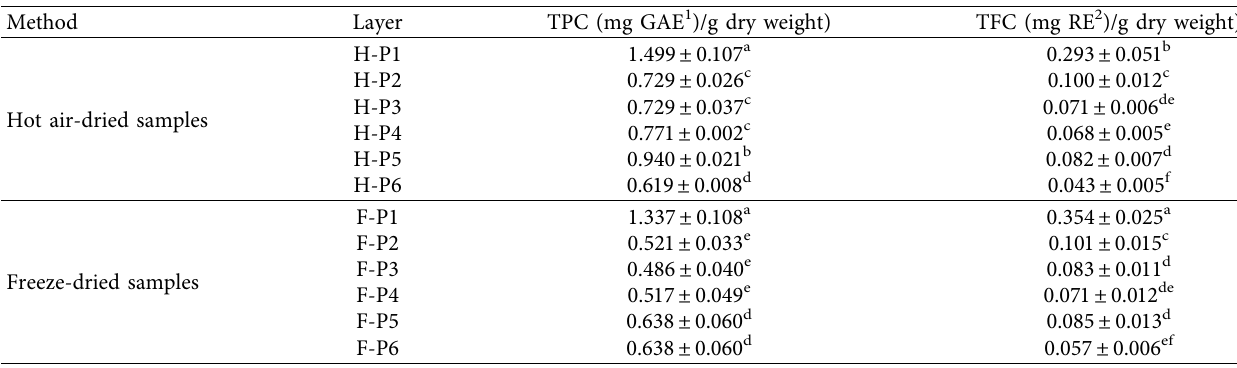
Table 1: Total polyphenol content (TPC) and total flavonoid content (TFC) of different cabbage leaf layers (mg/g dry weight powder